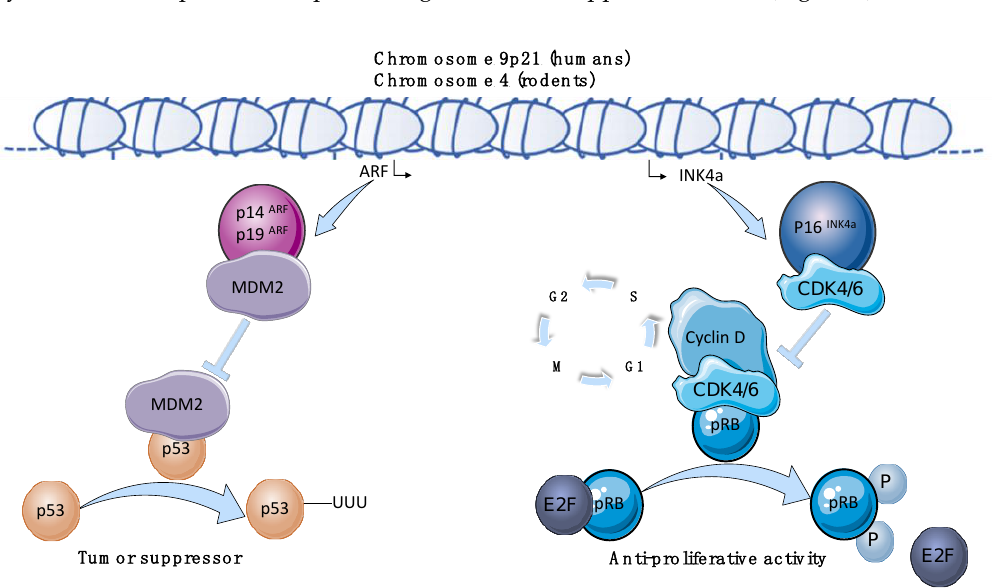
Figure 1. The INK4a / ARF locus. The INK4a / ARF locus is located on chromosome 9p21 in humans and chromosome 4 in rodents. It encodes for two proteins, p16INK4a the principal member of the INK4 family of cyclin-dependent kinase inhibitors (CDKI) and the p53 regulatory protein p14ARF (p19ARF in mice). Both are key regulators of the cell cycle machinery with an anti-proliferative and tumor suppressor role. p16INK4a binds to CDK4 / 6, inhibiting cyclin D-CDK4 / 6 complex formation and CDK4 / 6-mediated phosphorylation of Rb family members (pRB). Expression of p16INK4a maintains pRB in a hypophosphorylated state, which promotes binding to the transcription factors E2F and blocks the passage of the G1 to S phase. p14ARF (p19ARF in mice) mainly exerts its anti-proliferative activity via the inhibition of the mouse double minute 2 homolog (MDM2), an ubiquitin-ligase that hampers the activity of the transcription factor p53, acting as a tumor suppressor, blocking cells in G1 and G2 phase.